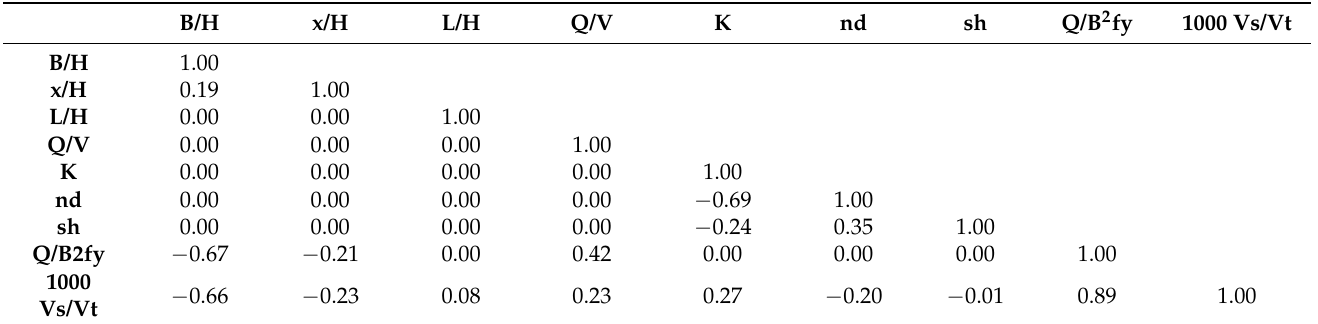
Table 2. Pearson correlation matrix.